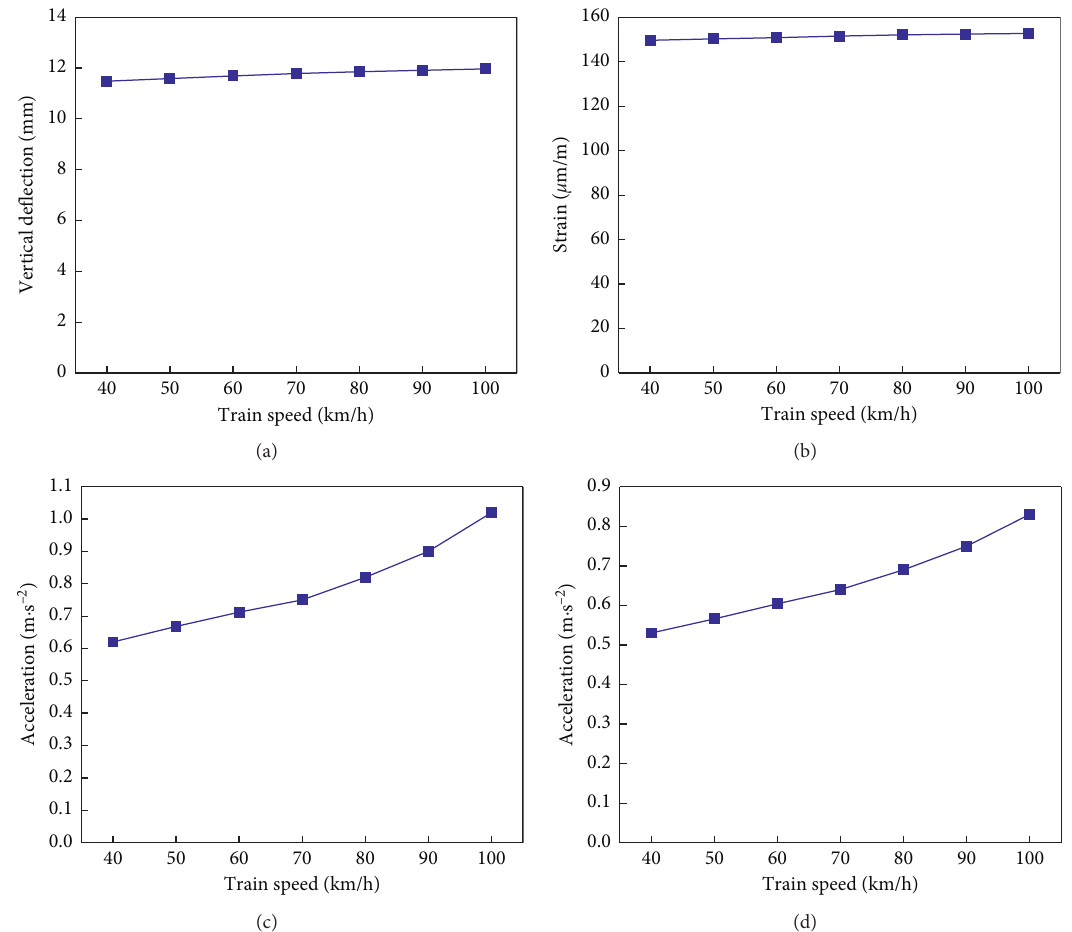
Figure 17: Maximum DR of the bridge girders’ mid-span section with various train speeds: (a) vertical deflection; (b) strain; (c) vertical acceleration; (d) lateral